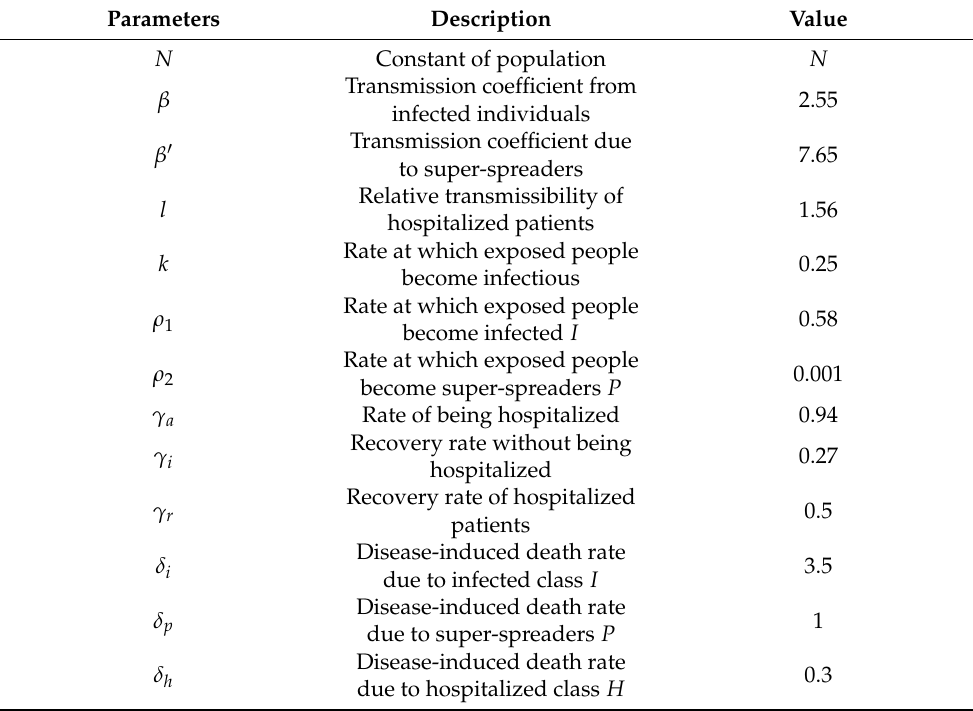
Table 1. Values of parameters presented in [18] according to situation in Wuhan. Parameters Description Value N Constant of population N Transmission coefficient from 2.55 infected individuals Transmission coefficient due to super-spreaders